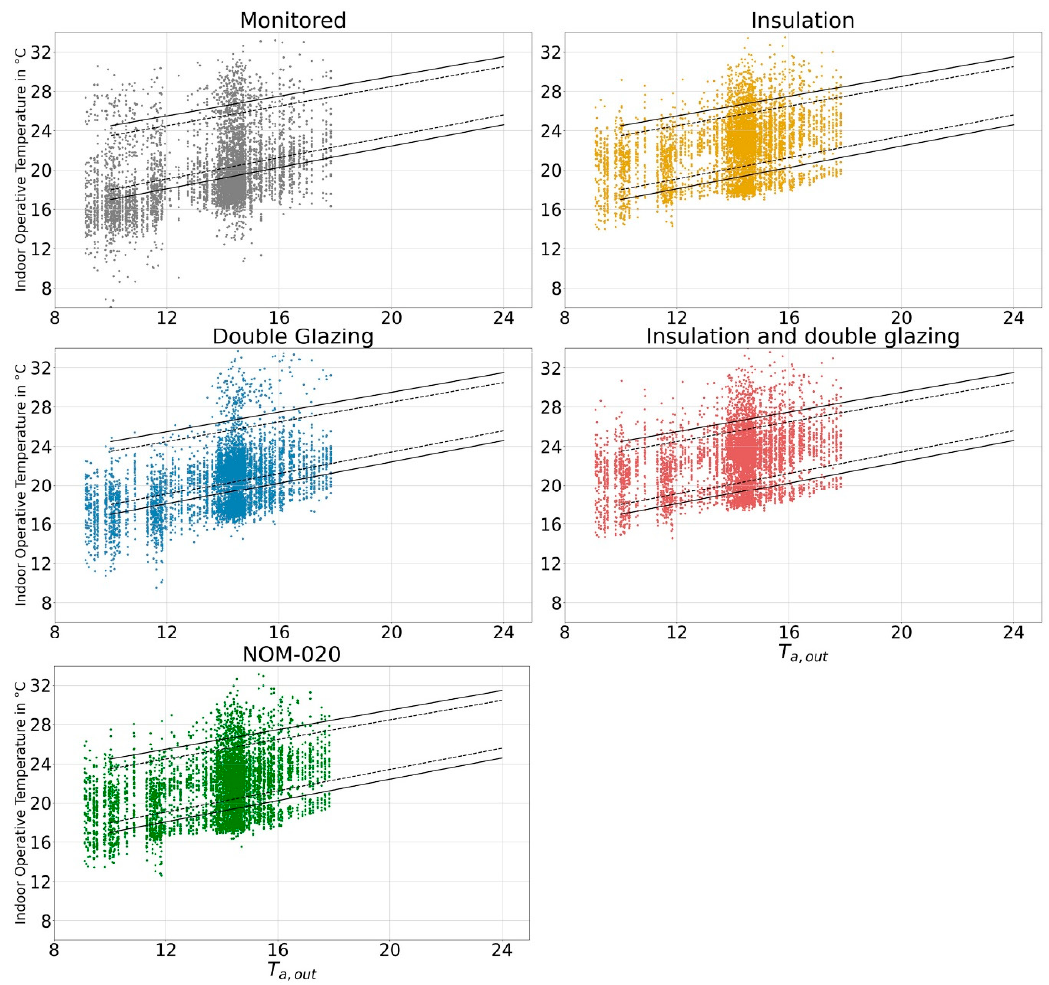
Figure 12. Adaptive approach graphs showing the outdoor running mean temperatures (°C) ( x -axis) and the indoor operative temperature (°C) ( y -axis) of the homes included in this study against the parameters established in the ASHRAE 55 standard. The segmented line (inner) represents 90% acceptability. The continuous (external) line represents 80% acceptability ASHRAE thresholds. Finally, the spots represent one hour (monitored or simulated). The top left (grey) shows the monitored (actual) temperatures. The different simulations provide the remaining results, as stated in each graph’s title.